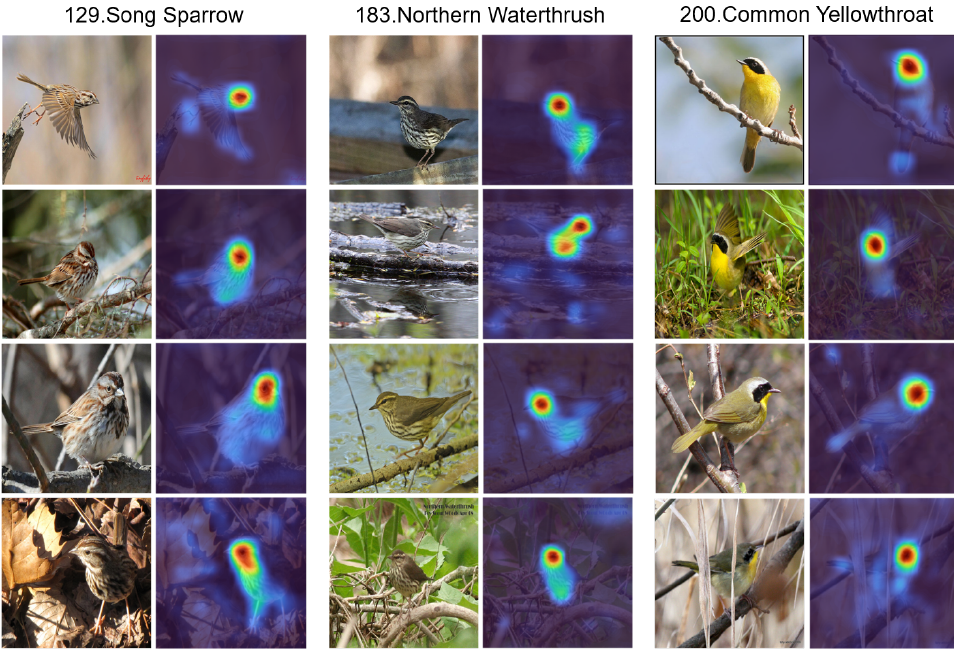
Figure 5. The recognition of fine-grained images by the GBP based model. The brighter the region is, the more attention the model pays to